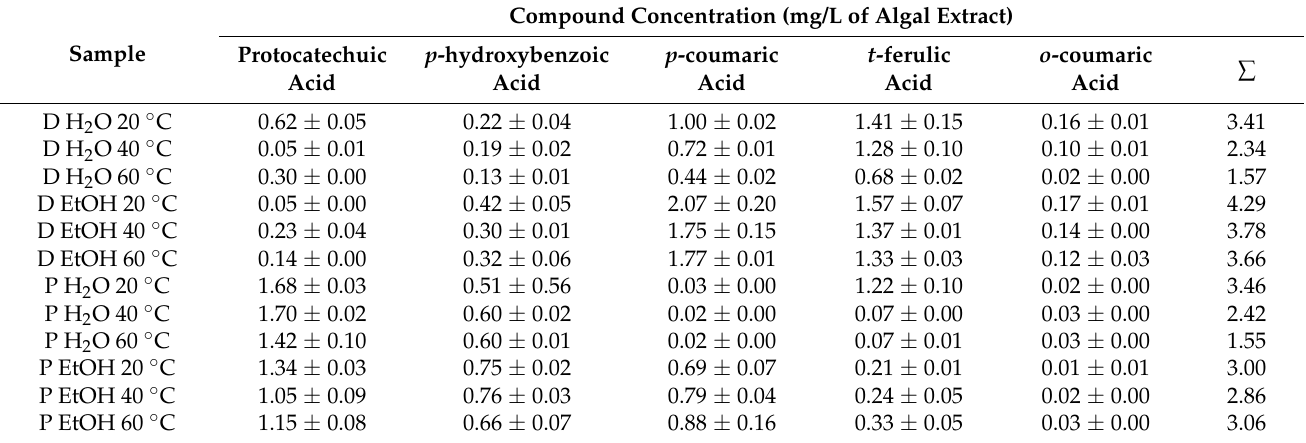
Table 1. Phenolic acids in Dictyota dichotoma (D) and Padina pavonica (P) extracts detected by HPLC.